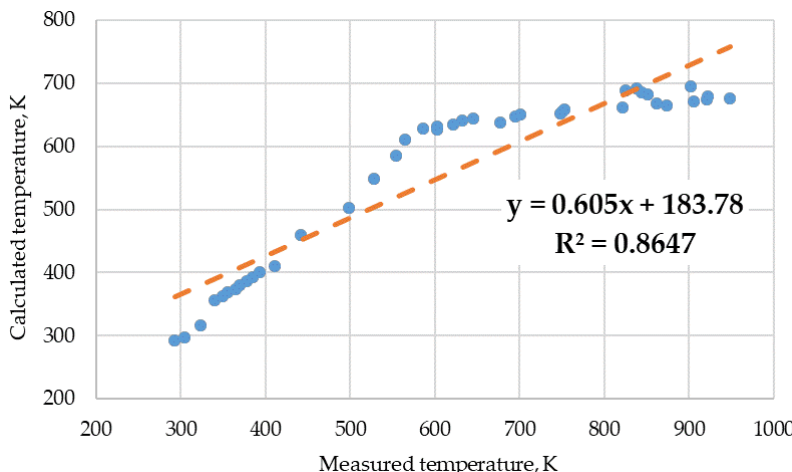
Figure 19. Correlation of measured and calculated temperature.